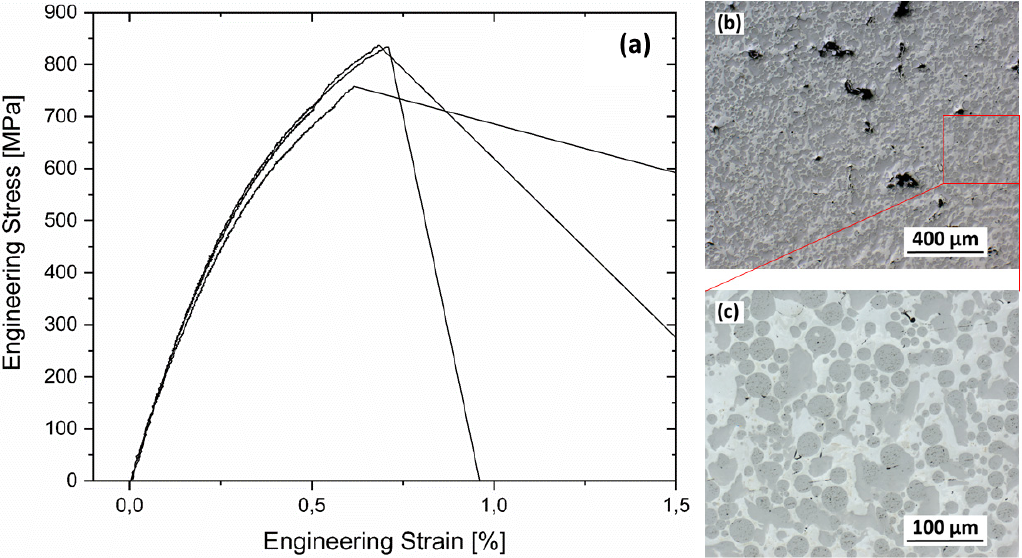
Figure 4. Tensile test. ( a ) Stress–strain curves of three comparable tensile test specimens with 60 vol% tungsten content; ( b ) Corresponding microstructure observed in a control sample; ( c ) Magnification of the left image. Corresponding main process parameters: 90 W, 500 mm/s, 0.07 mm and W 60 vol%.